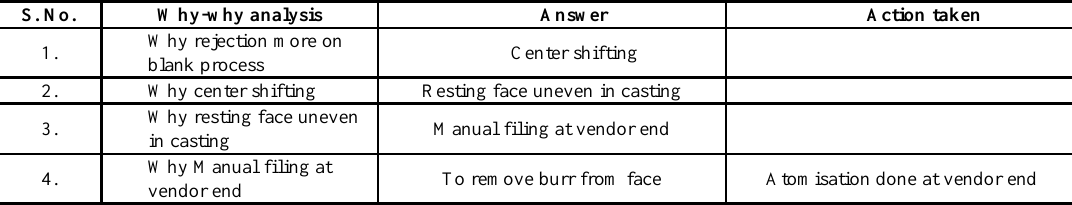
Table 2. Why-why analysis for axle hole shifting